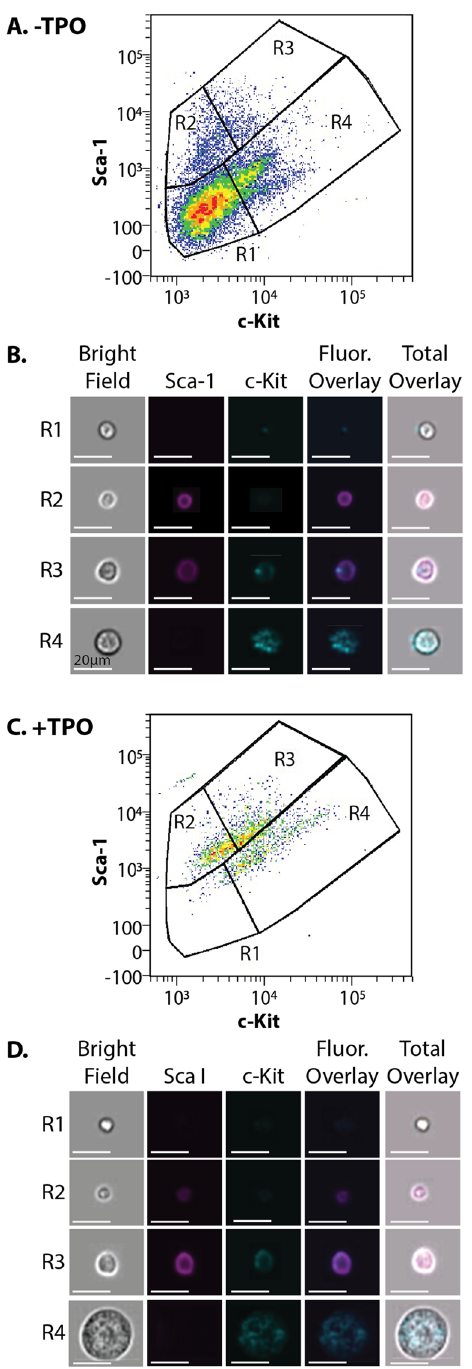
Figure 2. Characterization of progenitor cell subpopulations of mouse bone marrow cells. ( A ) Cells were harvested from the mouse bone marrow (− TPO), stained with LSK antibodies, and run on an image flow cytometer. Cells were gated for Lin - cells and the total population was divided into four distinct subpopulations (R1–R4). ( B ) As cells ran through the image flow cytometer, an image was captured of each cell. Representative images of the cells (− TPO) in each of each of the four subpopulations are represented. ( C ) Bone marrow cells grown in the presence of TPO (+ TPO), stained with LSK antibodies and run on the image flow cytometer. Cells were divided into four distinct subpopulations (R1–R4). ( D ) Representative images of the cells (+ TPO) panels of each of the four subpopulations are represented. Scale bars for all images, 20